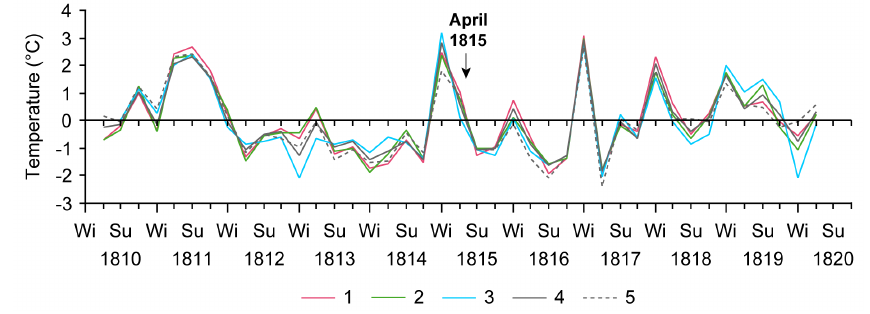
Figure 2. Seasonal temperature anomalies at Prague-Klementinum (1), Žitenice (2), Brno (3), in the Czech Lands (4) and central Europe (5) series around the time of Tambora eruption in 1815 (Wi – Winter, Su – Summer). Anomalies are expressed with respect to the 5-year period pre-eruption: month zero – April